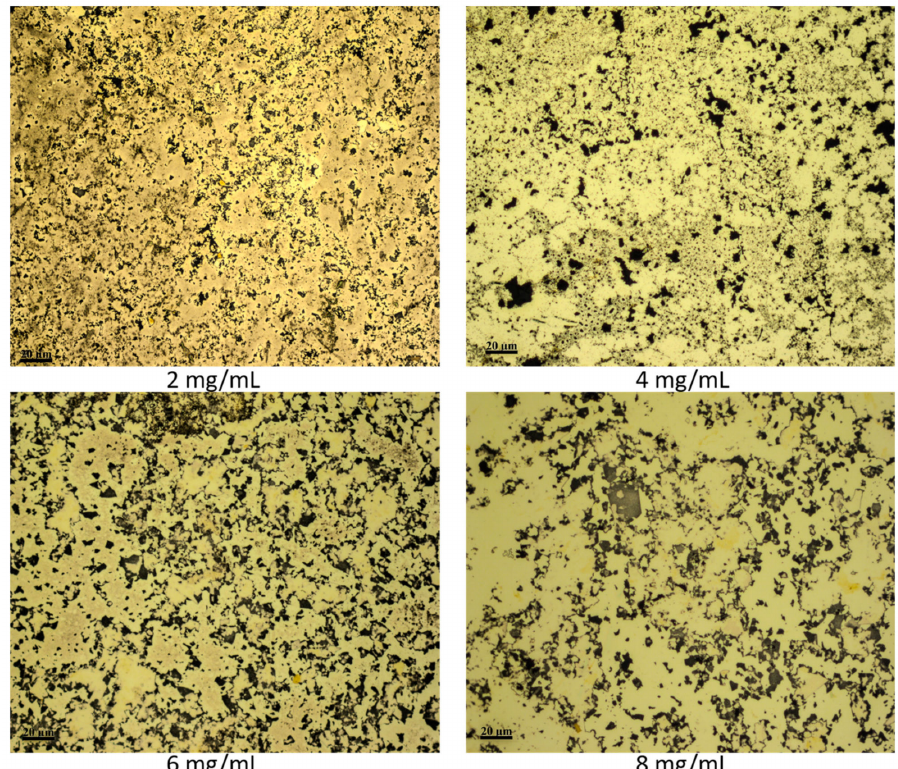
Figure 5. Etching of thin gold film over COC wafer with different concentrations of GO. The concentration of the GO for each sample is shown in the figure. All samples were etched for 15 s. All microscopic images were taken at the same